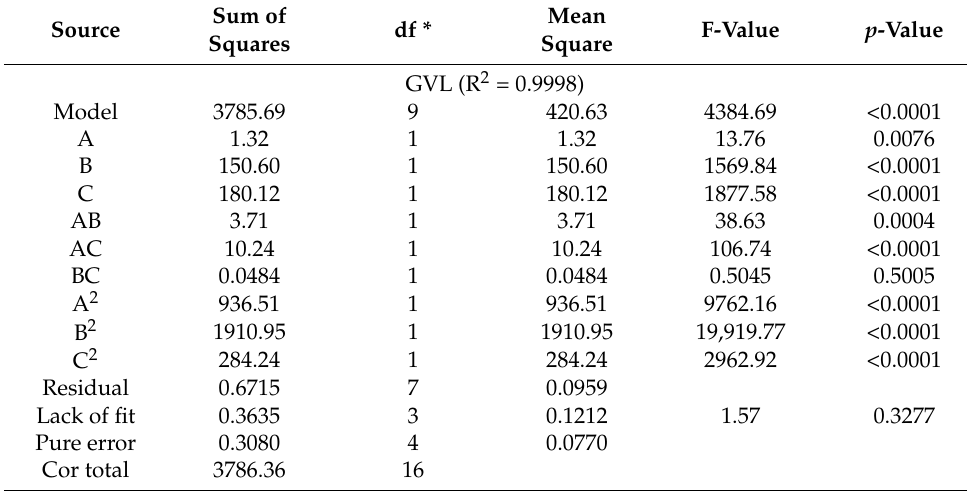
Table 3. ANOVA for the response surface quadratic model for GVL production as a function of time ( A ), temperature ( B ), and catalyst loading ( C